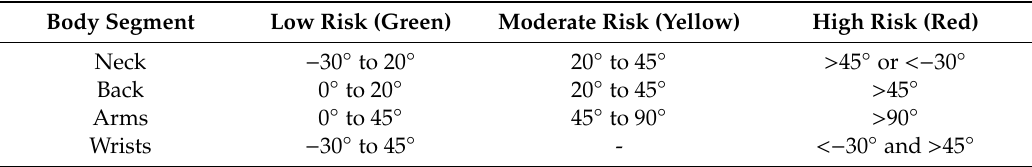
Table 2. The threshold limits of flexion / extension for di ff erent body segments based on the in-house observational method used in the factory under study (similar to ISO 11226: